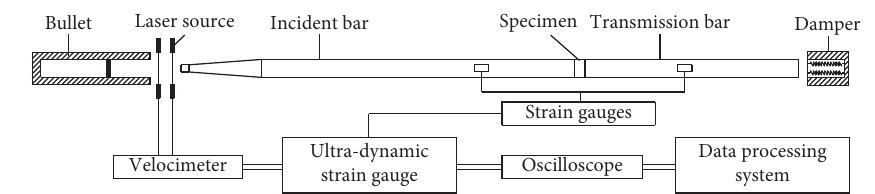
Figure 2: Schematic diagram of the SHPB test